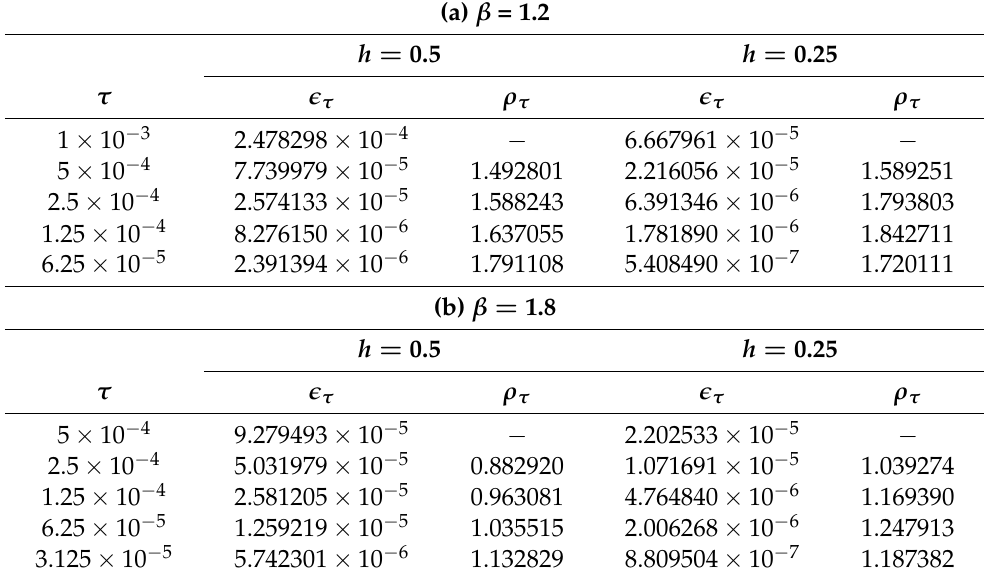
Table 1. Numerical study of the convergence of the finite-difference method (42). In this experiment, we let Ω = ( − 15,15 ) , α = 1.5, γ = 0 and F ( u ) = 1 − cos ( u ) , for each u ∈ R . We used homogeneous Dirichlet boundary conditions, and the initial data were prescribed by the function (92) around the time t = 0. Two values of β were used, namely, (a) β = 1.2 and (b) β = 1.8. Various values for the computational parameters τ and h were considered. The results confirm that the numerical method (42) has temporal order of convergence equal to τ 3 − β , in agreement with the theoretical results derived in this work. (a) β = 1.2 h =